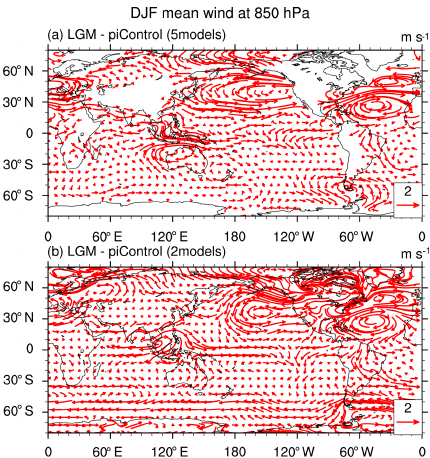
Figure 14. DJF mean 850hPa wind differences between LGME and piControl derived from (a) the five models and (b) the two mod- els. Only those areas where the signal-to-noise ratio exceeds 1 are